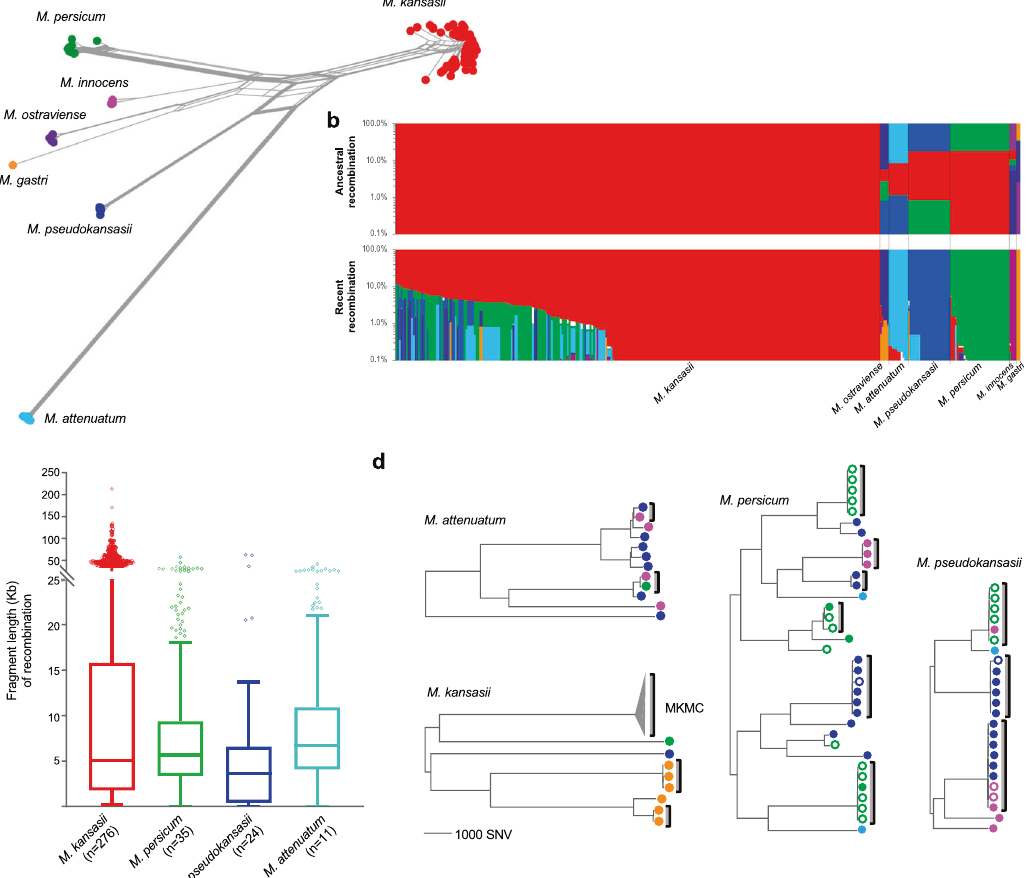
Fig. 2 Genomic recombination and its contribution in speciation and diversi fi cation of the M. kansasii complex. a Phylogenetic network of the M. kansasii complex based on the core genome alignment of 358 isolates. b Population structure and genomic recombinations inferred by fastGEAR. Each line represents the genomic constitution (exhibited as color strips) of individual isolates according to ancestral (upper panel) or recent (lower panel) recombinations. Strip colors represent the different species as in panel ( a ). White strips (lower section) represent recent recombinations from unknown sources. Source data are provided as a Source Data fi le. c Length distribution of recombinant fragments in the four major species. Boxes show the median and interquartile range (IQR) while whiskers extend to a maximum of 1.5× IQR. d Maximum likelihood phylogeny of the four major species based on non- recombinant SNVs. Brackets indicate clusters containing isolates with an average pair-wise genomic difference of fewer than 100 SNVs. The colors of terminal nodes indicate the geographical origins of the isolates, corresponding to Fig. 1a. Filled circles indicate a human source; empty circles, an environmental source. MKMC M. kansasii main